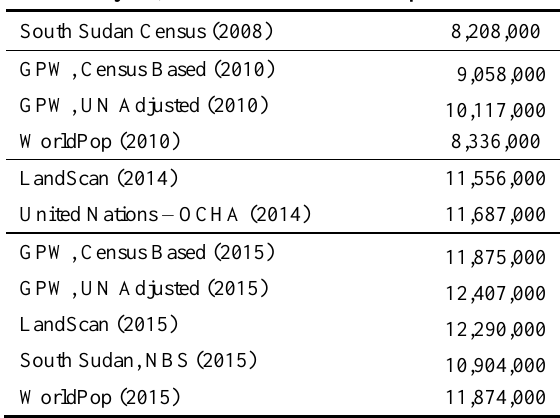
Table 1. Population Totals for South Sudan from Multiple